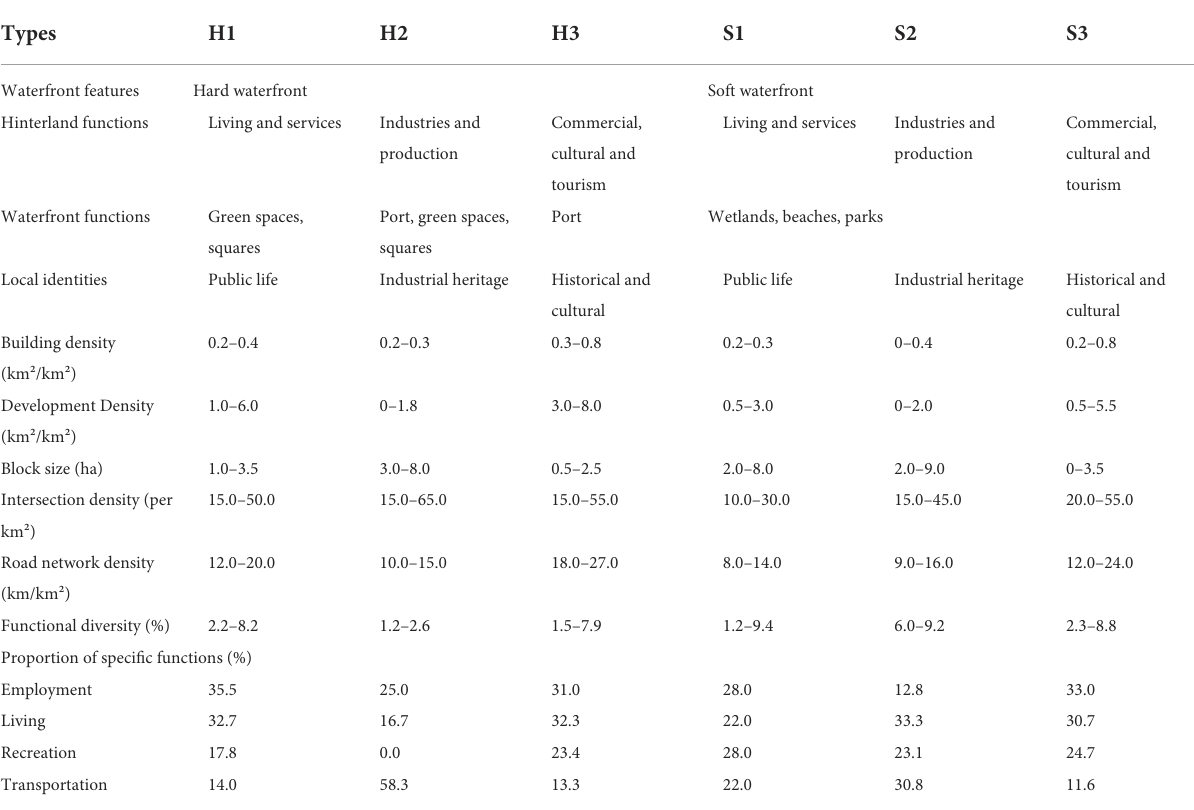
TABLE 5 Environmental drivers of coastal vitality based on typological